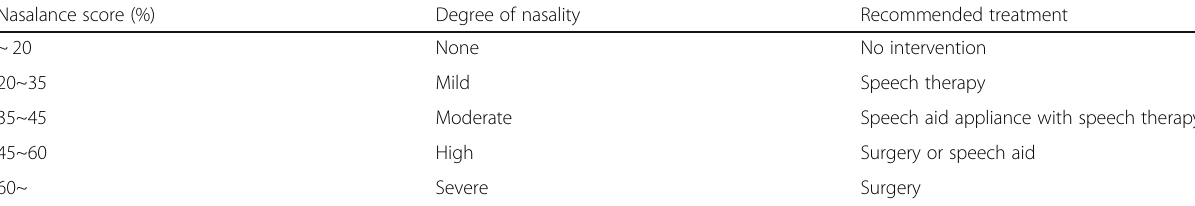
Table 2 Degree of nasality and recommended intervention methods (Shin ’ s criteria) Nasalance score (%) Degree of